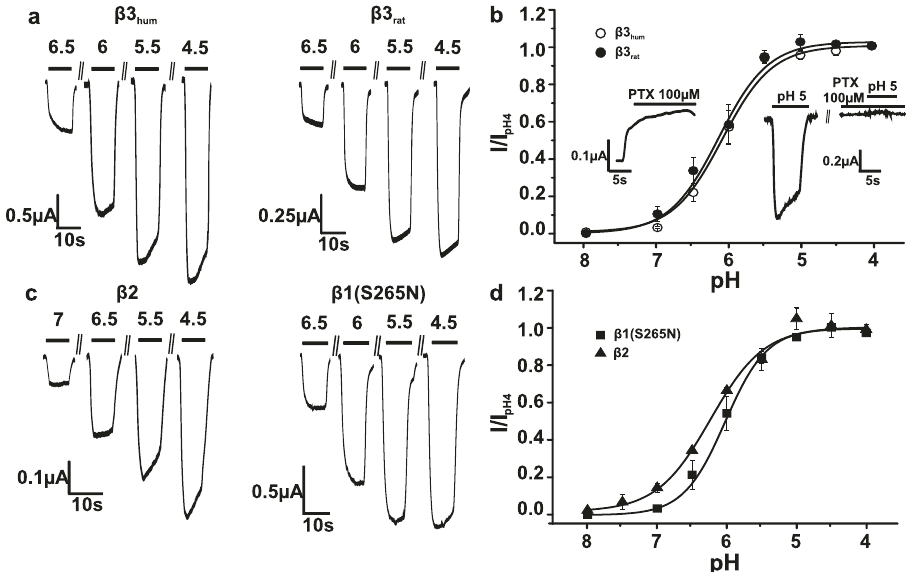
Fig. 1 Proton-induced currents (I H( β ) ) through homomeric GABA A β 1(S265N) , β 2 and β 3 receptors induced at a holding potential of -70 mV from pH of 9. a , c Representative I H( β ) through β 3 (human, rat), β 1 and β 2 subunit homomers elicited by rapidly switching the pH from 9 to the indicated values. b , d Normalized pH-response curve of I H( β ) through β 3 hum (pH 50 = 6.09 ± 0.2, n H = 1.25 ± 0.37), β 3 rat (pH 50 = 6.1 ± 0.01, n H = 1.25 ± 0.08), β 2 (pH 50 = 6.23 ± 0.13, n H = 1.07 ± 0.05) and β 1(S265N) (pH 50 = 6.03 ± 0.1, n H = 1.45 ± 0.21) homomers. The data are presented as mean values ±SEM, n = 5. The insets in ( b ) illustrate block of baseline current (left) and inhibition of I H( β )